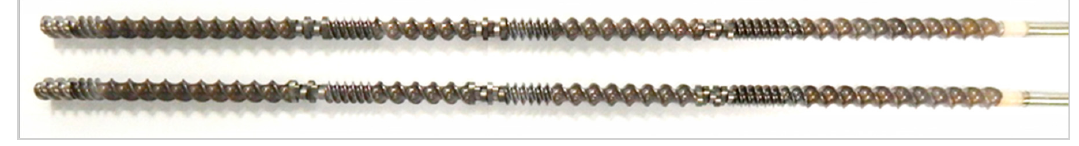
Table 4. Hot-melt extrusion (HME) process parameters.